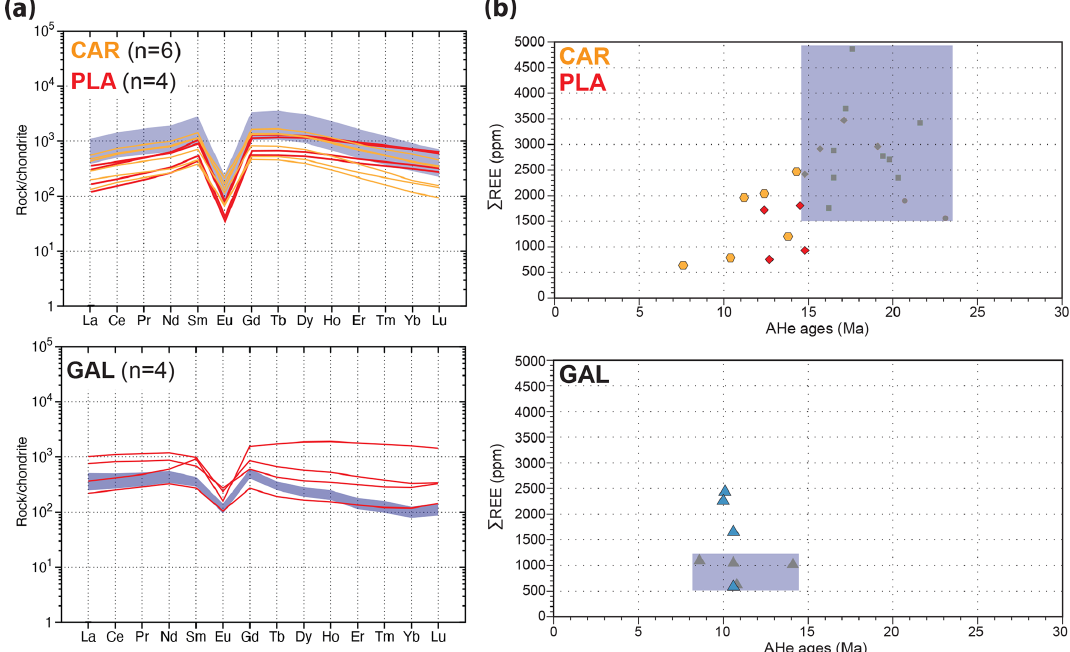
Figure 13. (a) Individual REE patterns of samples within the DZ; in the top part, the purple field is defined by 13 REE spectra (gneiss samples TET5, ST4, ST8, and PLA2) from outside the DZ. In the bottom part, the purple field comes from the four REE analyses from the GAL3 sample (outside the DZ). (b) Sum of REE contents as a function of AHe ages. The purple field corresponds to samples outside the DZ showing consistent REE patterns. The depletion of all REEs in PLA and CAR DZ samples is associated with a rejuvenation of AHe